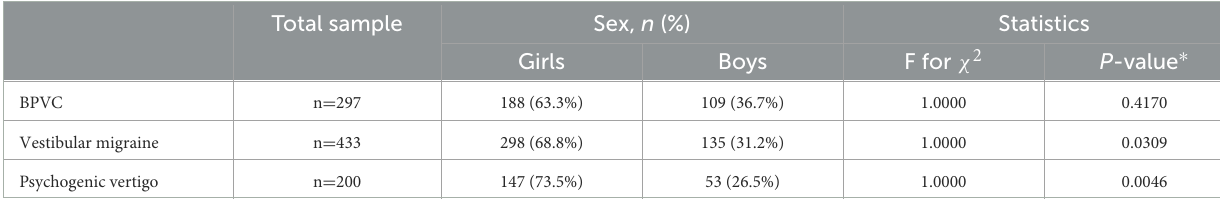
TABLE 6 The prevalence of BPVC, vestibular migraine and psychogenic vertigo in different gender.